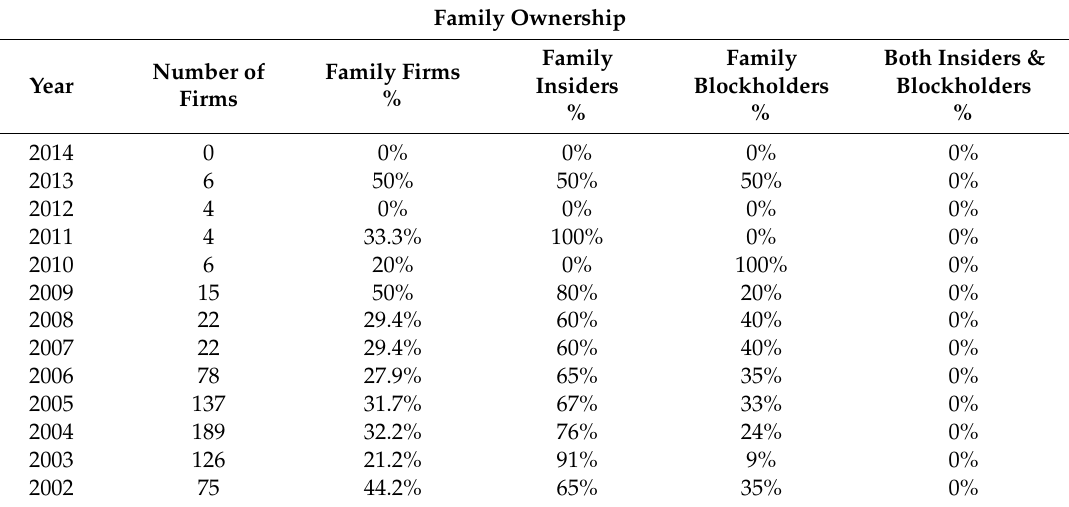
Table 6. Bankrupt Firms over the period 2014–2002.